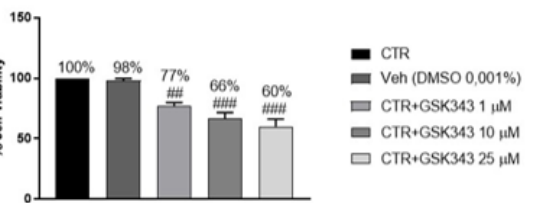
Figure 10. MTT assay revealed that GSK343 treatment (1, 10 and 25 μM) significantly reduced primary GB cell viability. Data are representative of at least three independent experiments. ## p < 0.01 vs. Ctr; ### p < 0.001 vs. Ctr.